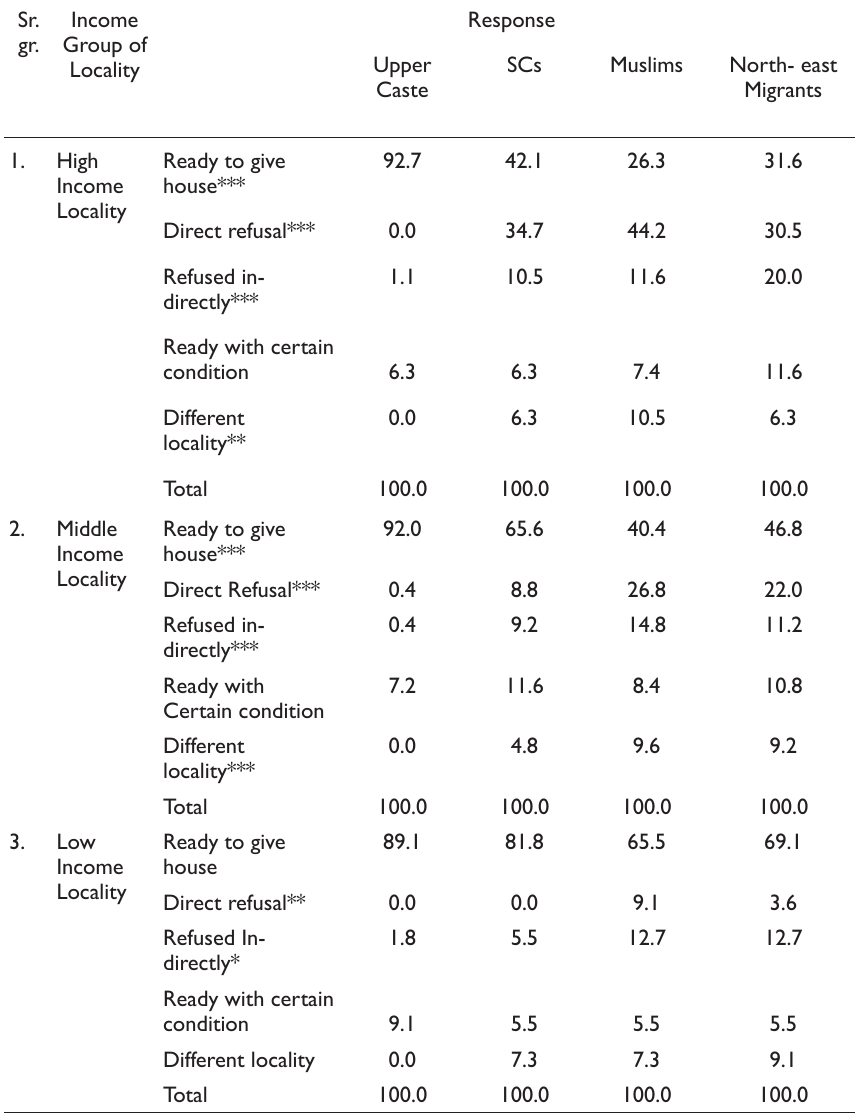
Table 9. Response by Social Group and Income Group of Locality (Telephonic) Sr.